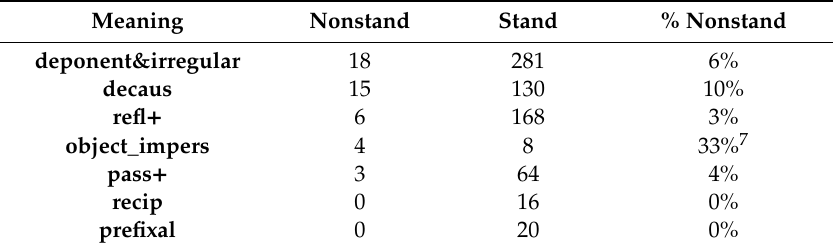
Table 3. Distribution across meanings of - s j a (Tungusic subcorpus).